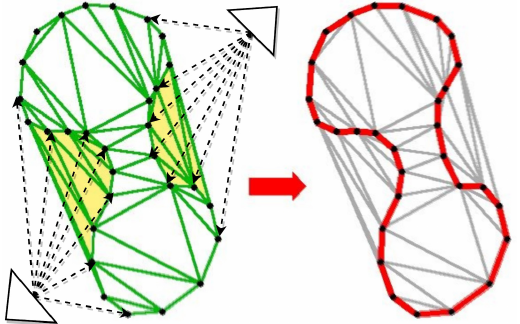
Figure 5. Left: Green network is Delaunay triangulation, yellow region (free space) are tetrahedra which intersected with rays (dash arrows), white region is tetrahedra labelled as full space. Right: Red lines are surfaces between full and free space, which are common faces shared by those tetrahedra.